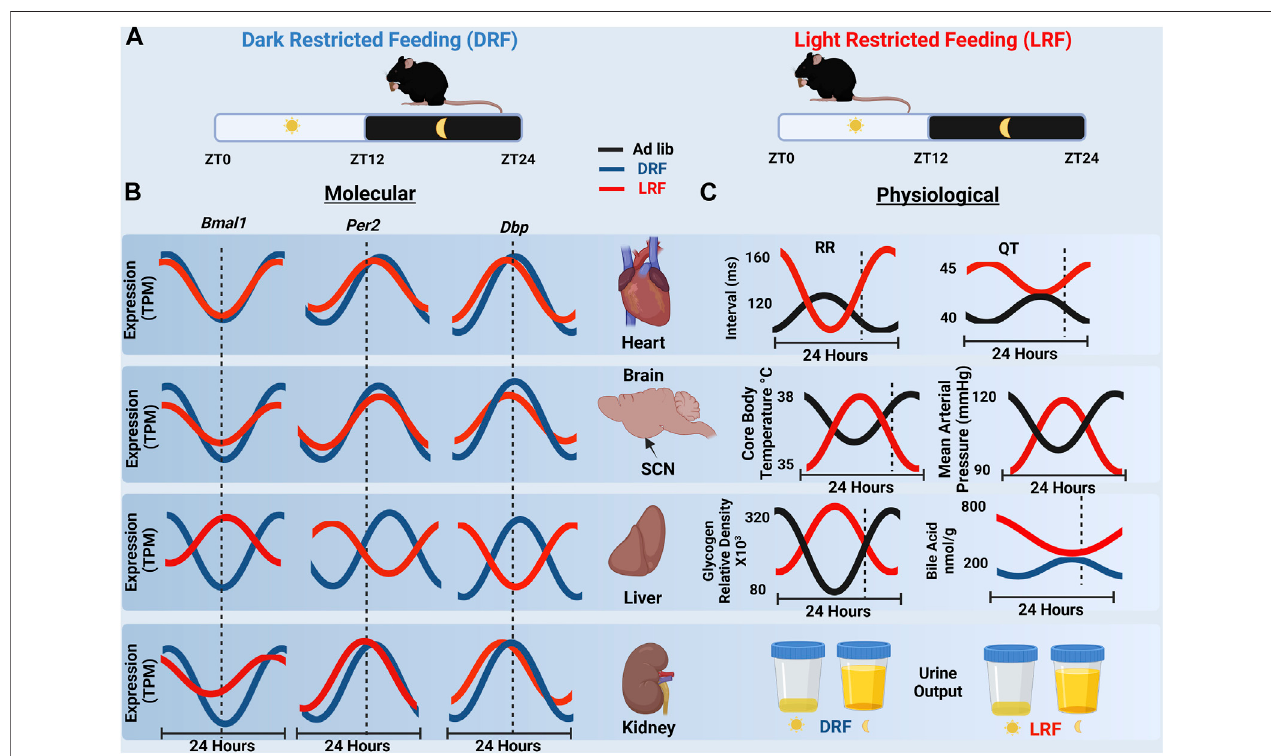
FIGURE 2 | (A) Schematic representation of nighttime restricted feeding (DRF), left, and daytime restricted feeding (LRF), right. (B) A cartoon representation of RNA-seq expression data of Bmal1 , Per2 and Dbp over 24 h in the heart, SCN, liver and kidney from mice undergoing DRF and LRF. The dashed line represents ZT12 which is the onset of dark cycle. Notice the ~12-h shift in gene expression in the liver which is not present in the heart, SCN, or kidney. (TPM, transcripts per million) (Xin et al.,2021) (C) Organ speci fi cphysiological rhythms inresponse toadlibitumfeeding,LRForDRF areshown.RRand QTintervalsrapidlyshiftinresponsetoLRF (Schroder et al., 2014). Similar shifts were observed with core body temperature (10) and MAP (27) which are regulated by the SCN under ad libitum conditions. Liver rhythms in liver glycogen content (Pérez-Mendoza et al., 2014) and bile acid production (Ma et al., 2009) also shifted in response to LRF. With the exception of urine output (Zhang et al., 2021) all physiological rhythms shown shift by ~12 h in response to LRF. (Created with